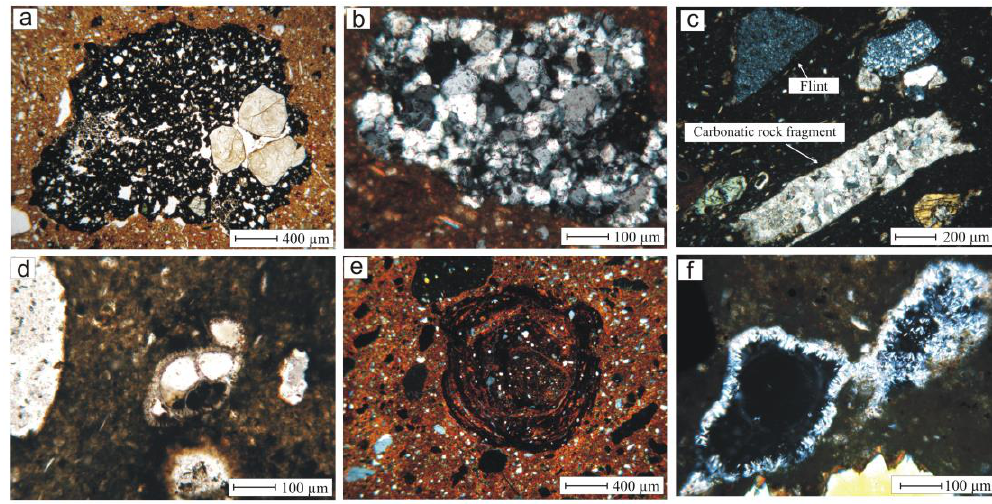
Figure 2. Microphotographs in thin section. All images are under crossed nicols, except for ( a ) and ( d ) which are under parallel nicols. ( a ) Volcanic rock fragment in sample S7. ( b ) Quartzite in sample S21. ( c ) Flint and carbonatic rock fragment in sample S12. ( d ) Bioclast in sample S13. ( e ) Argillaceous rock fragment (ARFs) in samples S3. ( f ) Secondary calcite inside porosity in sample S11.